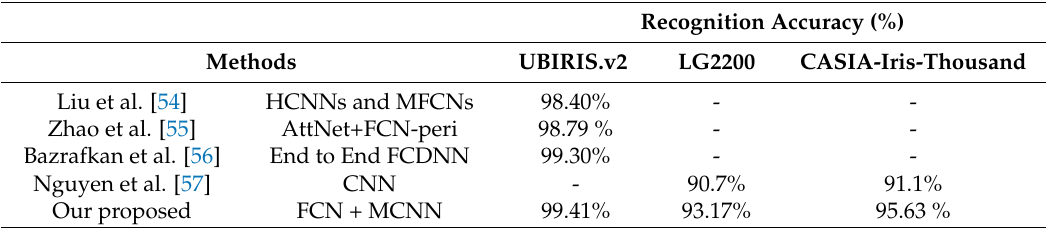
Table 3. Recognition Accuracy comparision of the proposed method with previous methods.